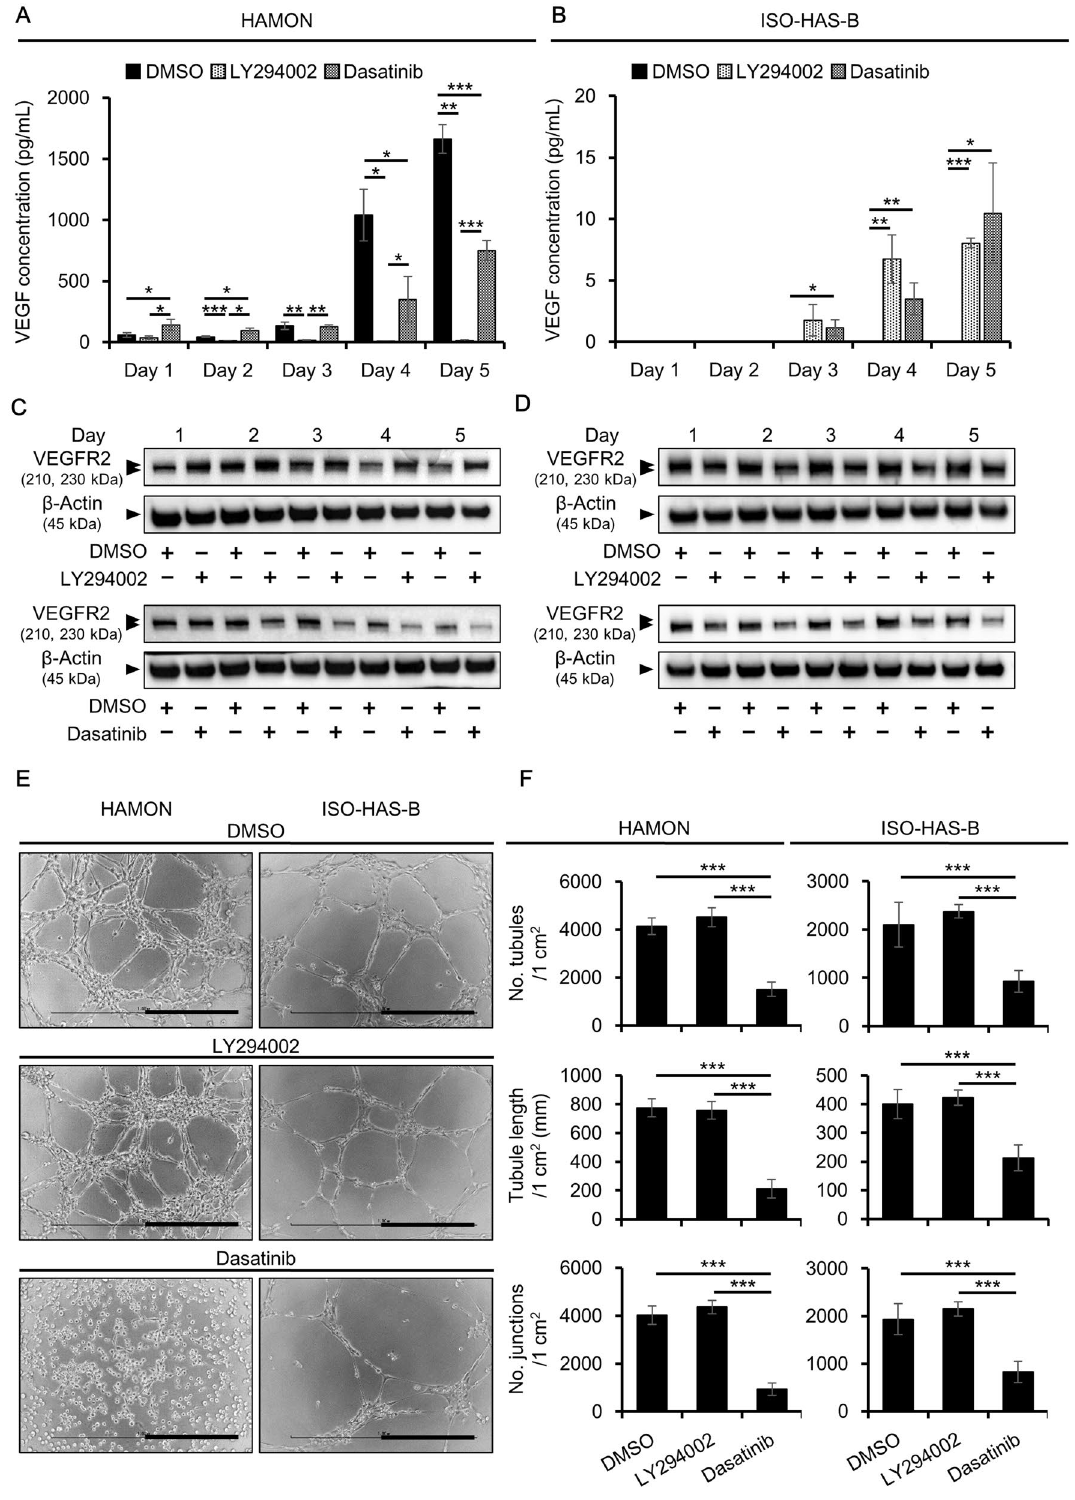
Figure 5. Inhibition of Src prevents angiogenesis in angiosarcoma cells. HAMON and ISO-HAS-B cells were treated with DMSO (0.1%), LY294002 (10 μM), or dasatinib (100 nM) for 1–5 days and assessed for angiogenesis. ( A,B ) VEGF protein concentration in the culture supernatant of ( A ) HAMON and ( B ) ISO-HAS-B cells. Data are the mean ± SD of three independent experiments. ( C,D ) Representative blot images of VEGFR2 and β-actin. The VEGFR2 signal was analysed using ImageJ software and was normalized against that of β-actin. The images shown derive from the same experiment and the blots were processed in parallel. Membranes were cut according to the molecular weight to separately hybridize with different antibodies and original blot images are presented in Supplementary Fig. S21. ( E ) Representative images of angiogenesis. Scale bars = 0.5 mm. ( F ) Number of tubules per 1 cm 2 , tubule length per 1 cm 2 , and the number of junctions per 1 cm 2 of DMSO-, LY294002-, and dasatinib-treated HAMON (left) and ISO-HAS-B (right) cells in the angiogenesis assay. Data are the mean ± SD of three independent experiments. * P < 0.05, ** P < 0.01, and *** P <